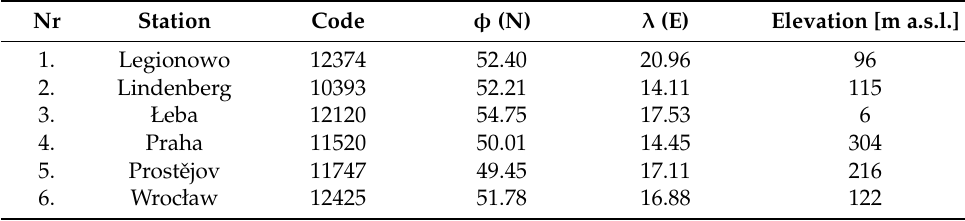
Table 2. Atmospheric sounding